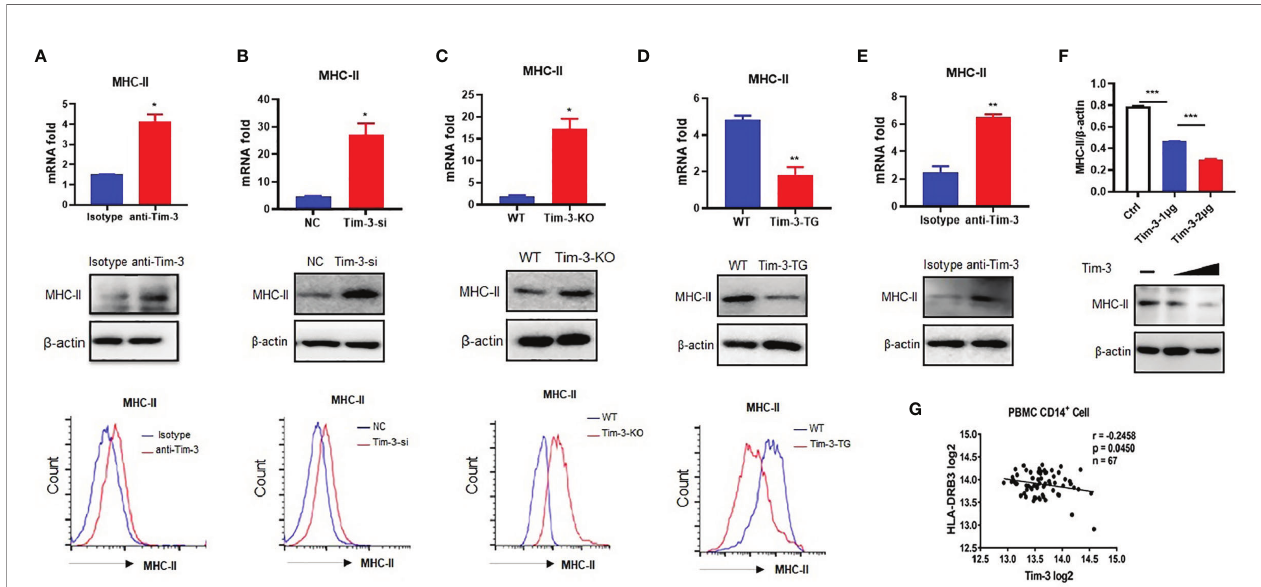
FIGURE 1 | Tim-3 inhibits MHC-II expression in macrophages. (A) The MHC-II expression of RAW264.7 cells cocultured with anti-Tim-3 antibody (20 m g/ml) or isotype antibody for 24 h (upper, mean ± SD, n = 3). (B) Tim-3 knockdown (Tim-3-si) RAW264.7 cells and (negative control, NC) RAW264.7 cells (upper, mean ± SD, n = 3). (C) The peritoneal macrophages from Tim-3 knockout mice (Tim-3-KO) and WT mice (upper, mean ± SD, n = 6). (D) The peritoneal macrophages from Tim-3 transgenic (Tim-3-TG) mice and wild-type (WT) mice. The MHC-II expression was detected by cytometry, Western blot, and RT-PCR (mean ± SD, n = 6). (E) WT mice were treated with anti-Tim-3 antibody or isotype antibody (10 mg/kg) by intraperitoneal injection at 0 and 24 h, and peritoneal macrophages were collected at 48 h to detect MHC-II protein and gene levels (mean ± SD, n = 6). (F) 1 and 2 m g of Tim-3 plasmid and 2 m g of vector plasmid were transferred into HEK-293T cells, respectively, and MHC-II protein level was detected at 48 h. (G) The expression data of Tim-3 and MHC-II in CD14+ monocytes/macrophages from 67 healthy individuals were collected from the GEO dataset (GSE34151), and their correlation was analyzed (*p < 0.05; **p < 0.01; ***p <